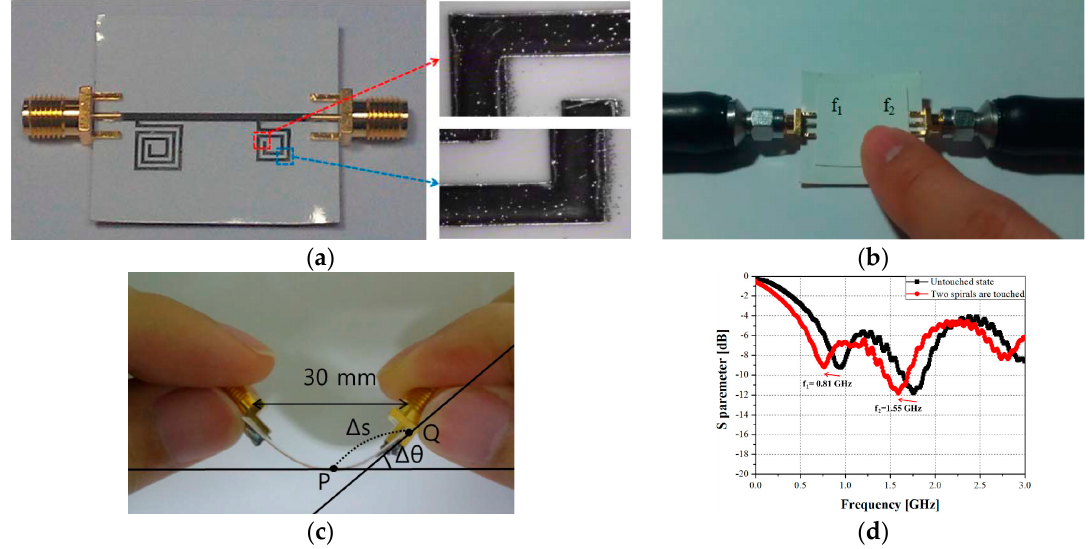
Figure 8. Touchpad: inkjet-printed spiral resonator on photo paper (redrawn from [69]). ( a ) Fabricated prototype of the touchpad ( b ) when one spiral is touched, ( c ) side view of the bent touchpad at a specific curvature ratio and ( d ) measured S21 when both spiral resonators are touched.